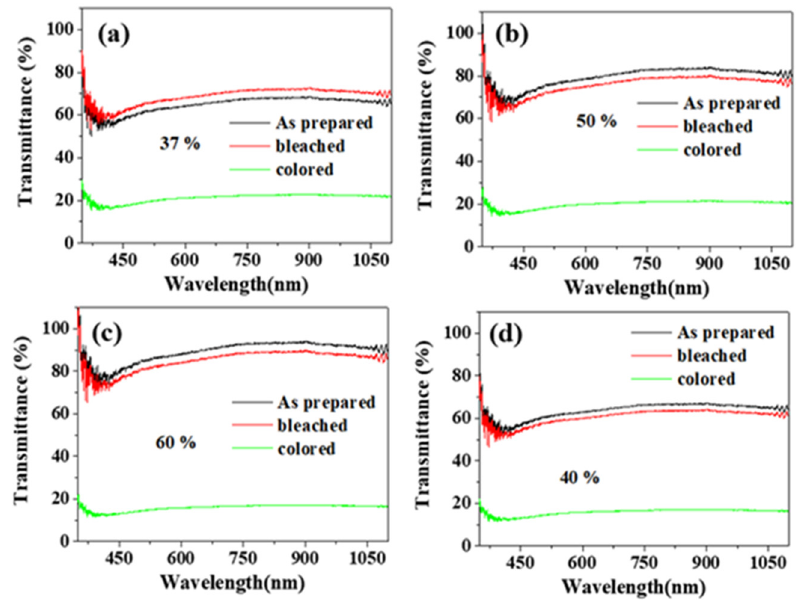
Figure 7. Cyclic voltammograms of WO 3 nanostructured electrodes at a scanning rate of 50 mV/s. The transmittance changes of ( a ) WO 3 1 h, ( b ) WO 3 4 h, ( c ) WO 3 9 h, and ( d ) WO 3 18 Table 1. Comparison of Electrochromic Properties.